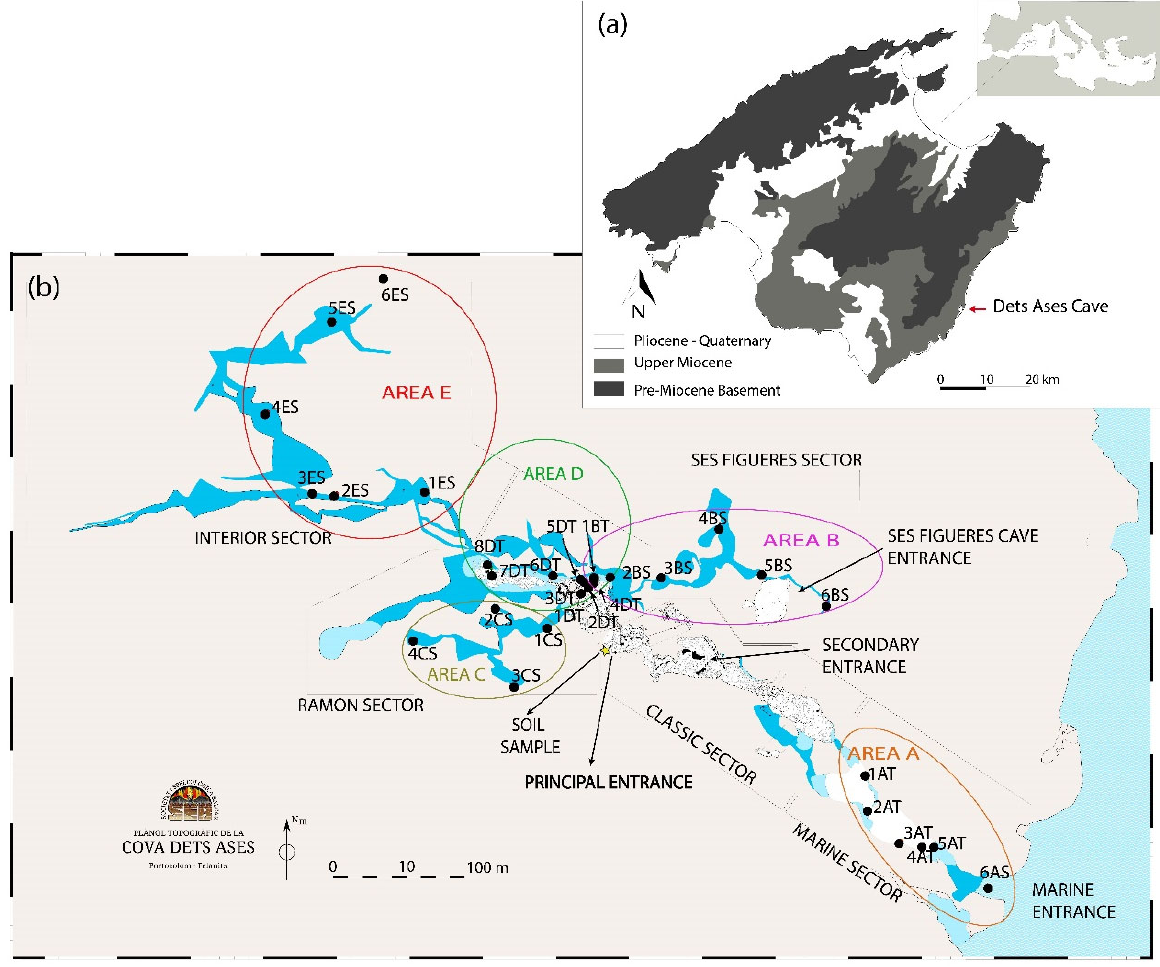
Figure 1. ( a ) Simplified geological map of the Mallorca Island in the western Mediterranean Sea showing the location of the Ases cave on the east coast (modified from Tuccimei et al. [33]); ( b ) Ases cave map with the different sectors of the cavity and areas where the samples have been taken (Societat Espeleològica Balear, unpublished).